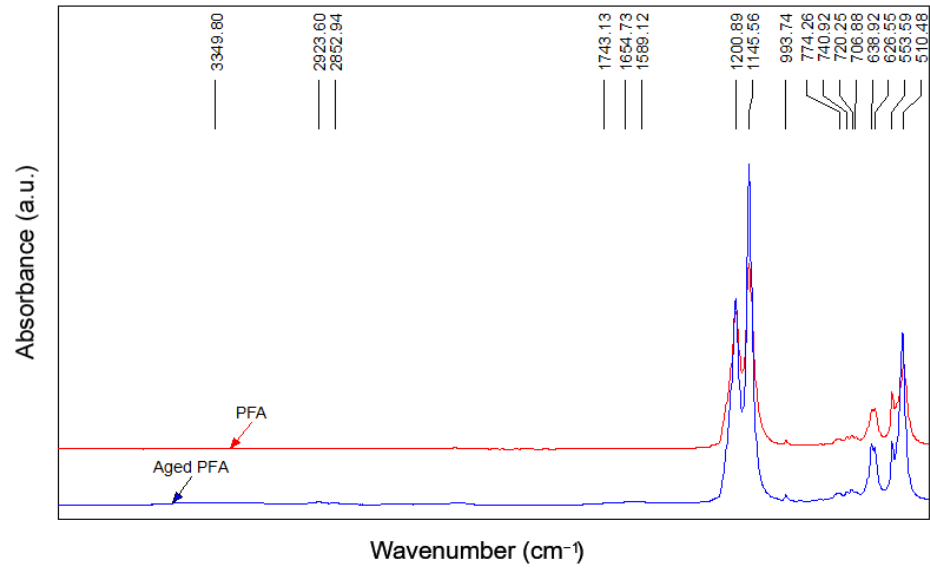
Figure 13. FTIR spectra of PFA films before and after aging.